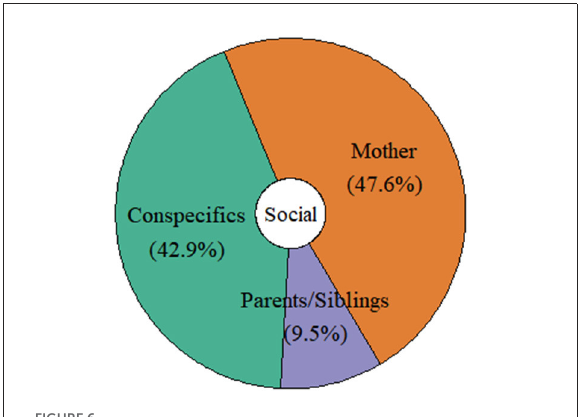
FIGURE6 Distribution of the distinct social partners interacting with infants/juveniles in the reviewed